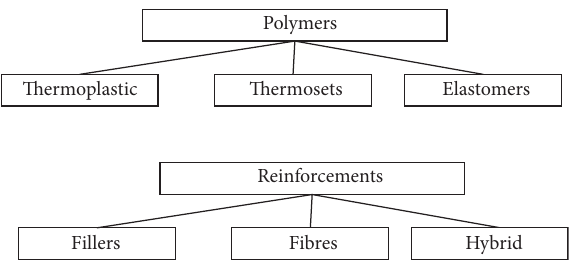
Figure 1: Classification and reinforcements of